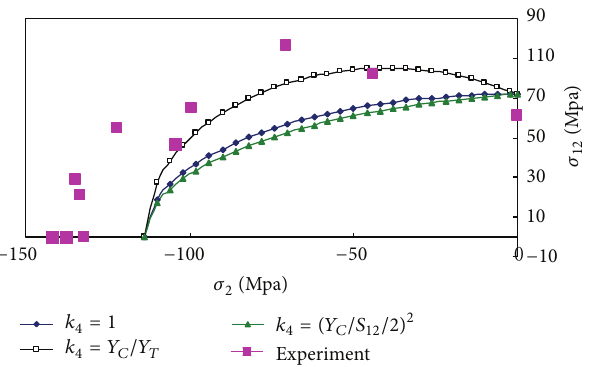
Figure 4: Matrix compressive failure